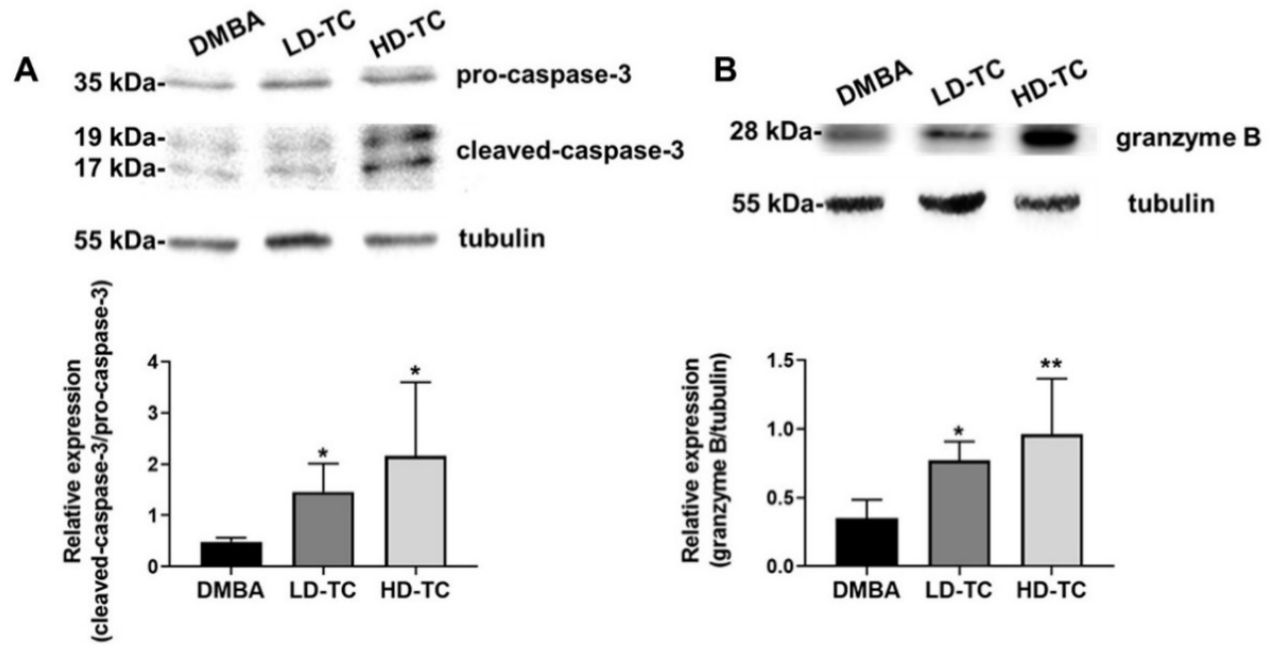
Figure 5. Effects of theacrine on the expression levels of cleaved-caspase-3/pro-caspase-3 and granzyme B in tumor tissues of DMBA-treated rats. Tumor tissues were harvested and analyzed through western blotting using antibodies against caspase-3 ( A ) and granzyme B ( B ). The expression of tubulin was used as an internal control. The results were shown as mean ± SD ( n = 6). Values were found statistically significant at p < 0.05; * p < 0.05, ** p < 0.01 as compared with the DMBA group.